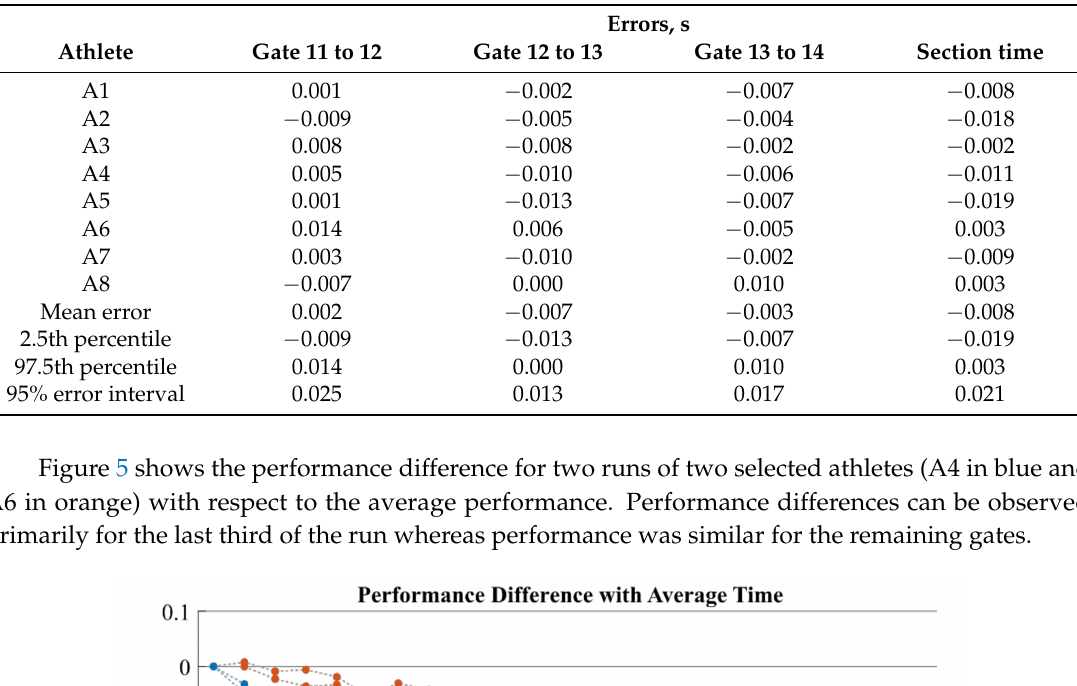
Table 1. Errors of the magnet-based system with respect to the photocell system.